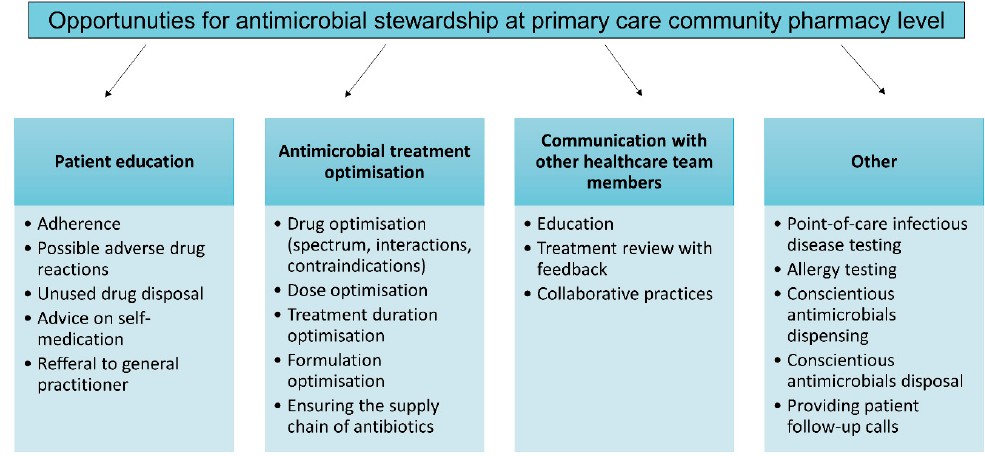
Figure 1. Antimicrobial stewardship opportunities in community pharmacies.